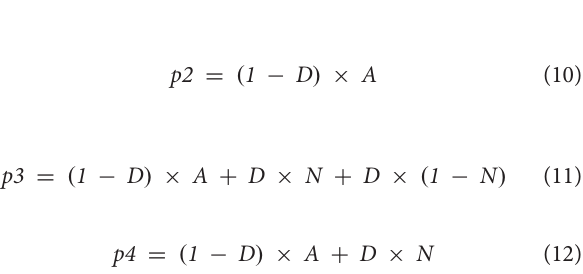
FIGURE 2 | An alternative multinomial processing tree model constructed on the corrective dual-process model of morality. D denotes that the agent’s choices are driven by moral principles (norms or consequences), N denotes that the agent’s choices are driven more by norms. (1 – N ) denotes that the agent’s choices are driven more by consequences. A denotes that the agent’s choices are driven by an overall preference for